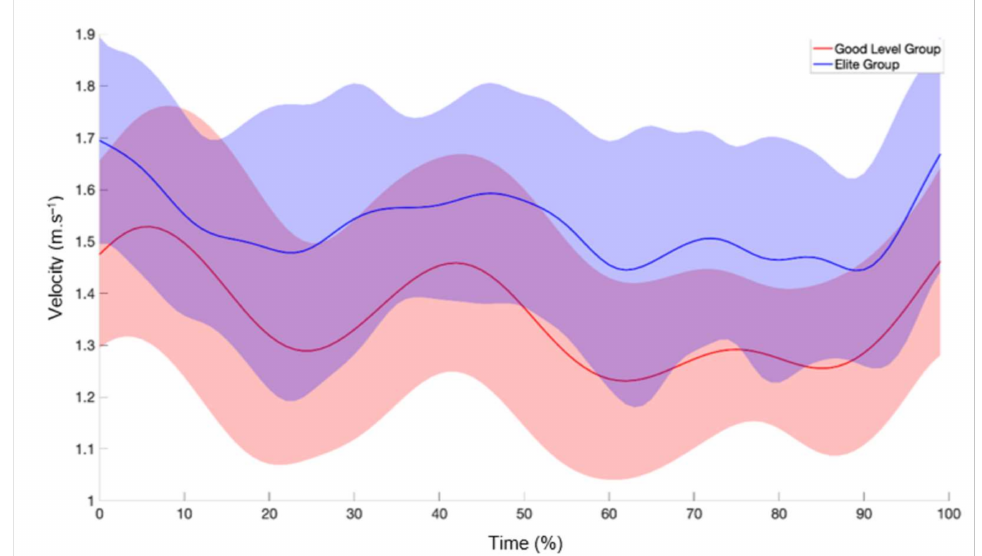
Figure 3. Elite and good-level groups’ mean velocities and SDs (blue and red lines and shades,